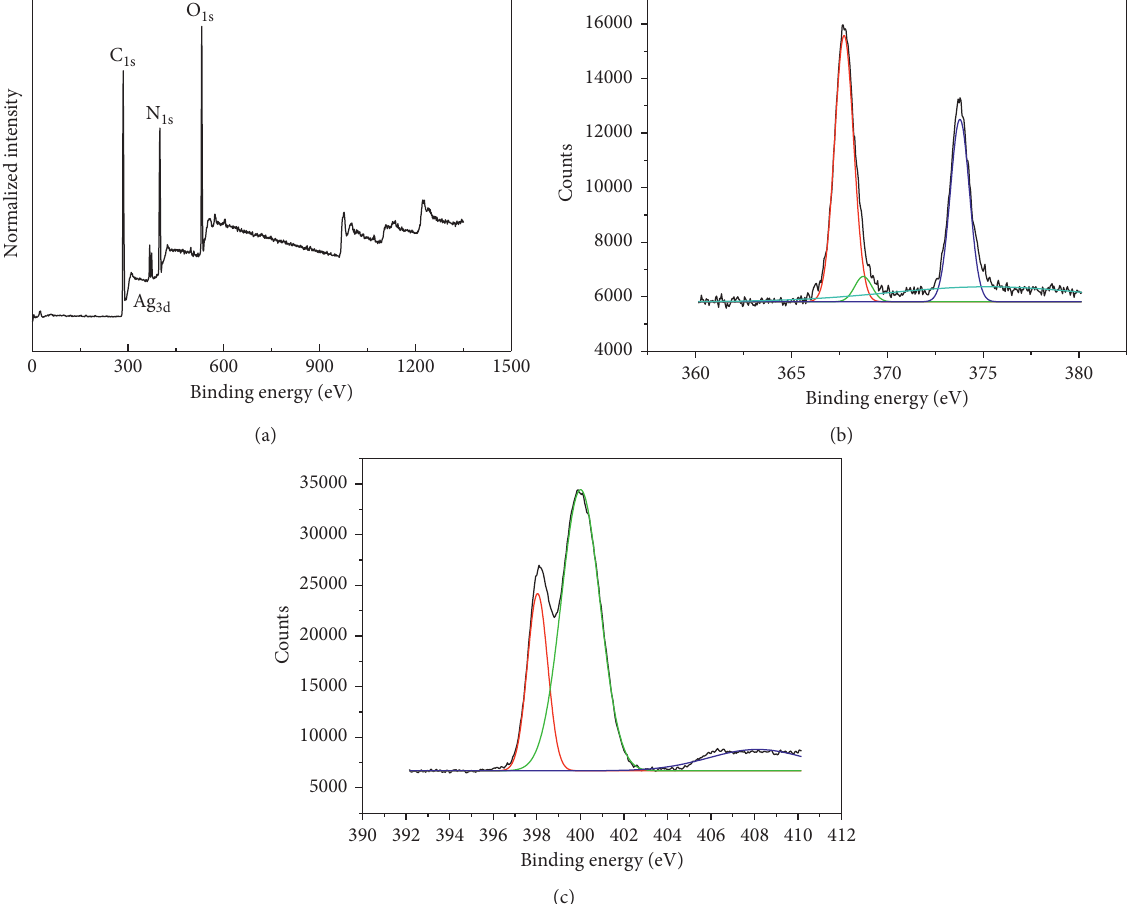
Figure 2: (a) XPS survey spectrum of the Ag NCs. (b-c) High-resolution XPS spectra of Ag